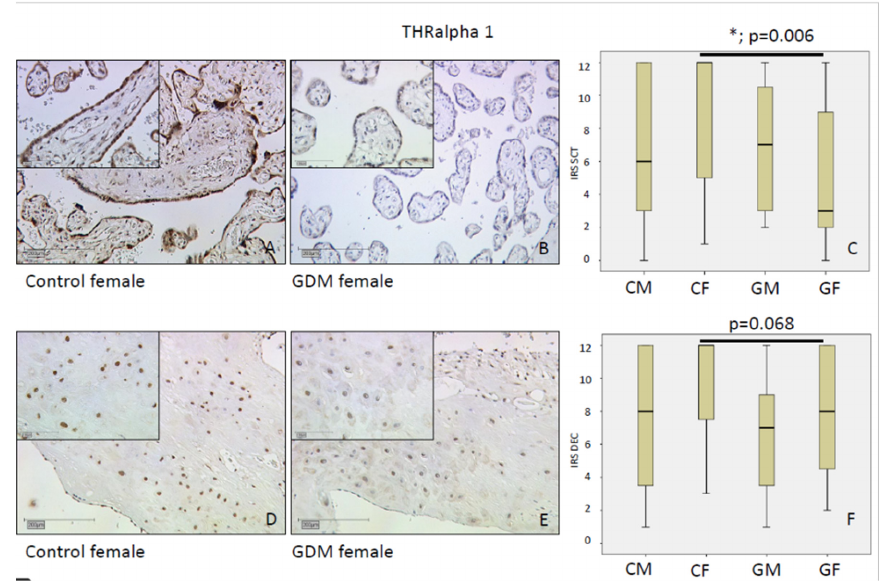
Figure1. Thyroidhormonereceptor(THR) α 1immunoreactivitywithanoverallhighintensityinnormal syncytiotrophoblast (SCT, A ) and in decidua ( D ). In SCT of female gestational diabetes (GDM) ( B ), we identified reduced immunolabelling of THR α 1 in comparison to control female SCT ( A ). In decidua of female GDM ( E ), we found similar reduced staining intensity in comparison to female controls ( D ). Immunoreactivity scores (IRS) for each group are shown as box plots for syncytiotrophoblast (IRS SCT) ( C ) and the decidua (IRS DEC) ( F ). The boxes represent the range between the 25th and 75th percentiles with a horizontal line at the median. The bars delineate the 5th and 95th percentiles. Groups are labelled as follows: CM = control male; CF = control female; GM = GDM male; GF = GDM female. Scale bars = 200 µ m in full size images and 100 µ m in